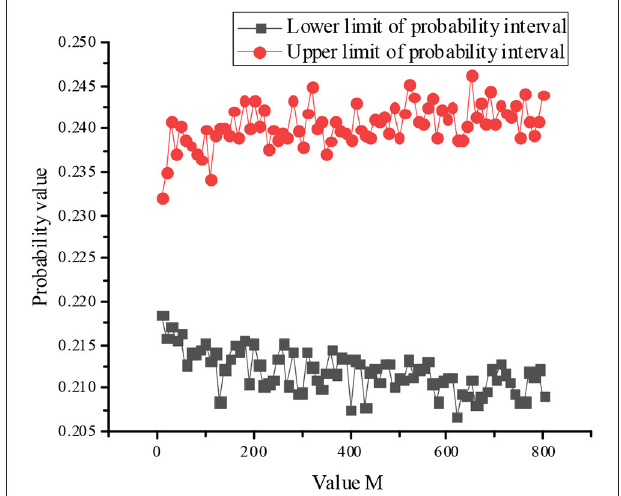
FIGURE 2 | Change law of failure probability with number change of outer layer sampling.